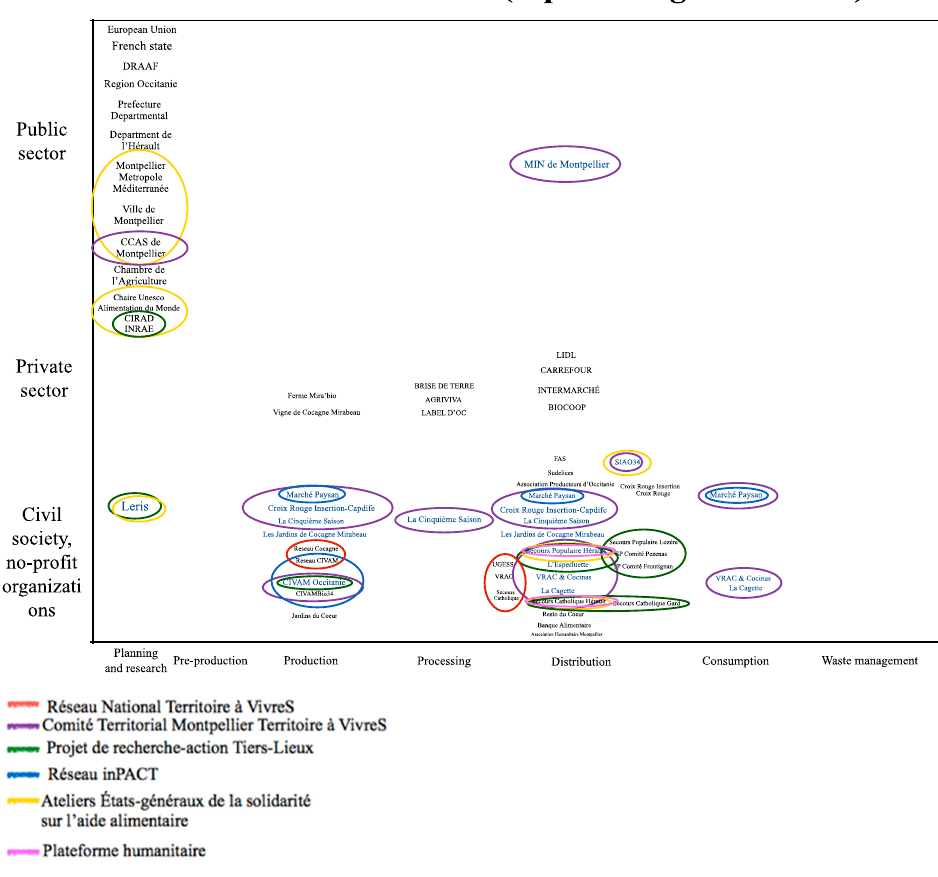
Figure 5. The six “spaces of governance” identified.